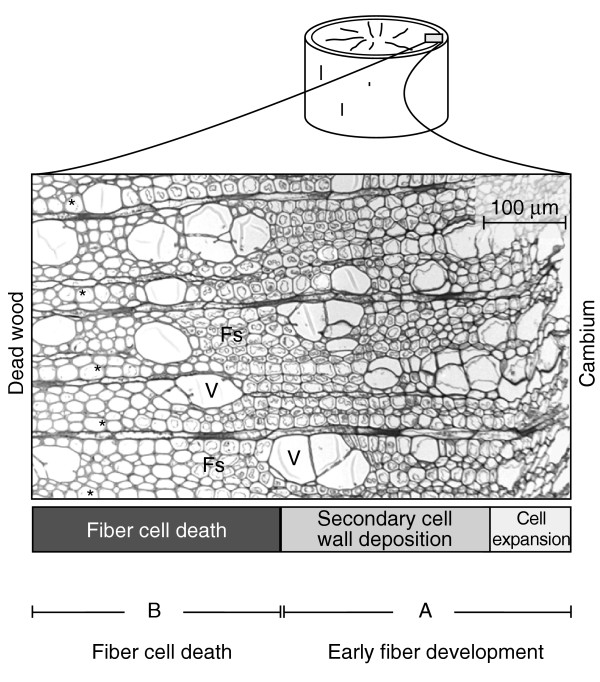
Sampling of xylem tissues. A transverse section from the base of the stem showing xylem tissues sampled from a Populus tree for the microarray and the RT-PCR analysis. The bark was peeled off resulting in a fracture in the cambial zone. For RT-PCR analysis, the different xylem tissues were successively scraped from the surface of the exposed stem to the border with the dead wood. For microarray analysis, the tissues were pooled into two samples: A (early fiber development) and B (fiber-cell death). The fiber-cell death sample corresponded closely to the tissues collected for construction of the fiber death cDNA library [13]. V, dead vessel; Fs, developing fibers. Note that the development of vessels is completed within the region of cell expansion, and that the fibers develop at a much slower pace, visualized by the gradual loss of the cytoplasm of the fibers. The asterisks denote fibers close to the moment of death with barely detectable cytoplasm.